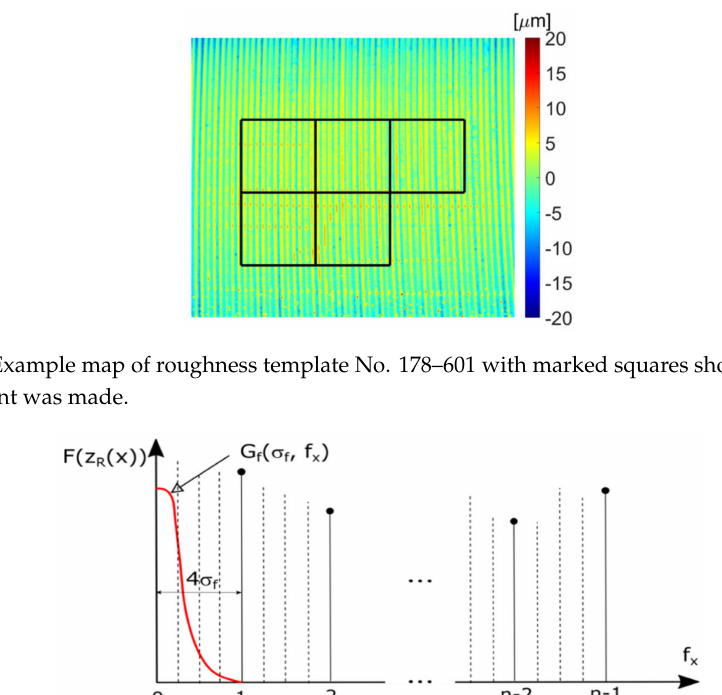
Figure 11. Explanation of waviness elimination by Gaussian filtering in the OCT surface map frequency domain along the horizontal direction: G f —waviness selecting Gaussian filter profile; σ f —Gaussian filter standard deviation in the frequency domain; n —number of roughness map samples inside any measurement square in Figure 9a or Figure 10; F ( z R ( x )) —Fourier spectrum magnitude for the fixed row y inside the surface map z R ( x , y )